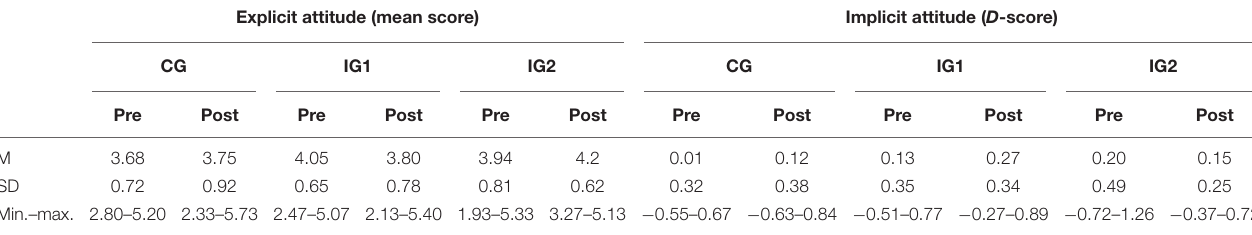
TABLE 1 | Descriptive data on explicit and implicit attitudes toward inclusion for each group before (pre) and after (post) intervention. Explicit attitude (mean score) Implicit attitude ( D -score)